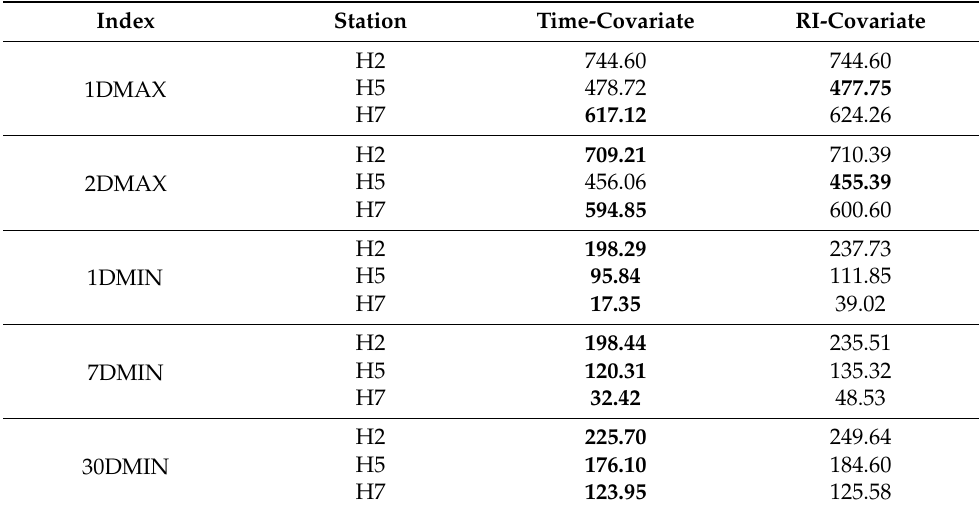
Table 9. Comparison of Akaike Information Criterion (AICs) for the time-covariate and Reservoir Index (RI)-covariate best-fitted